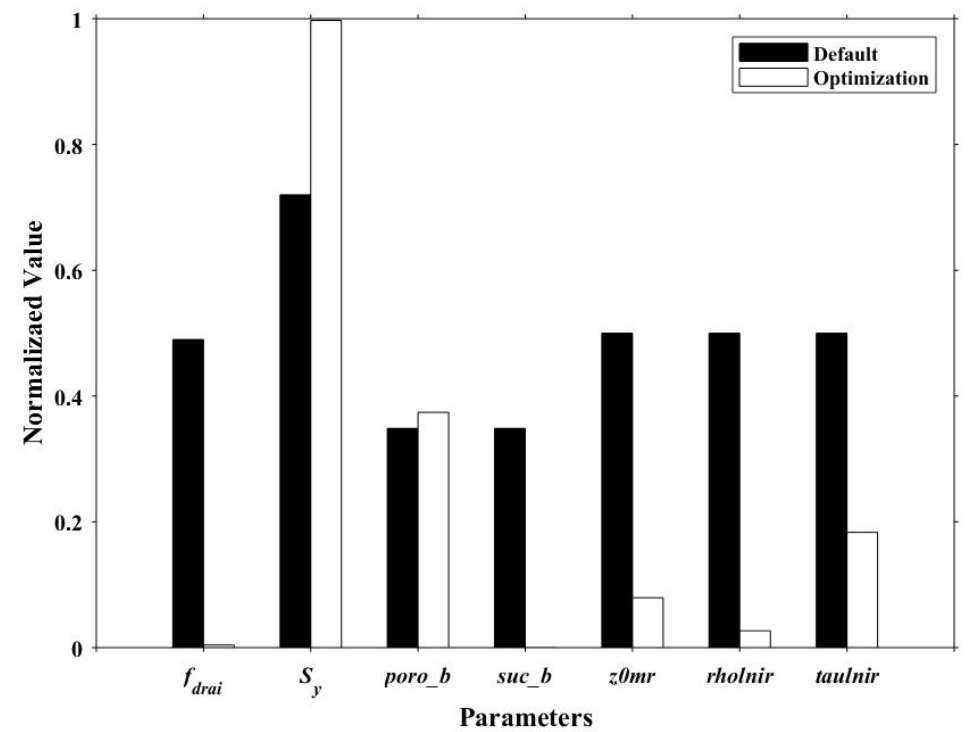
Figure 11. Comparisons of normalized optimal and default parameter values of Community Land Model version 4.0 model for the evapotranspiration simulations in China.